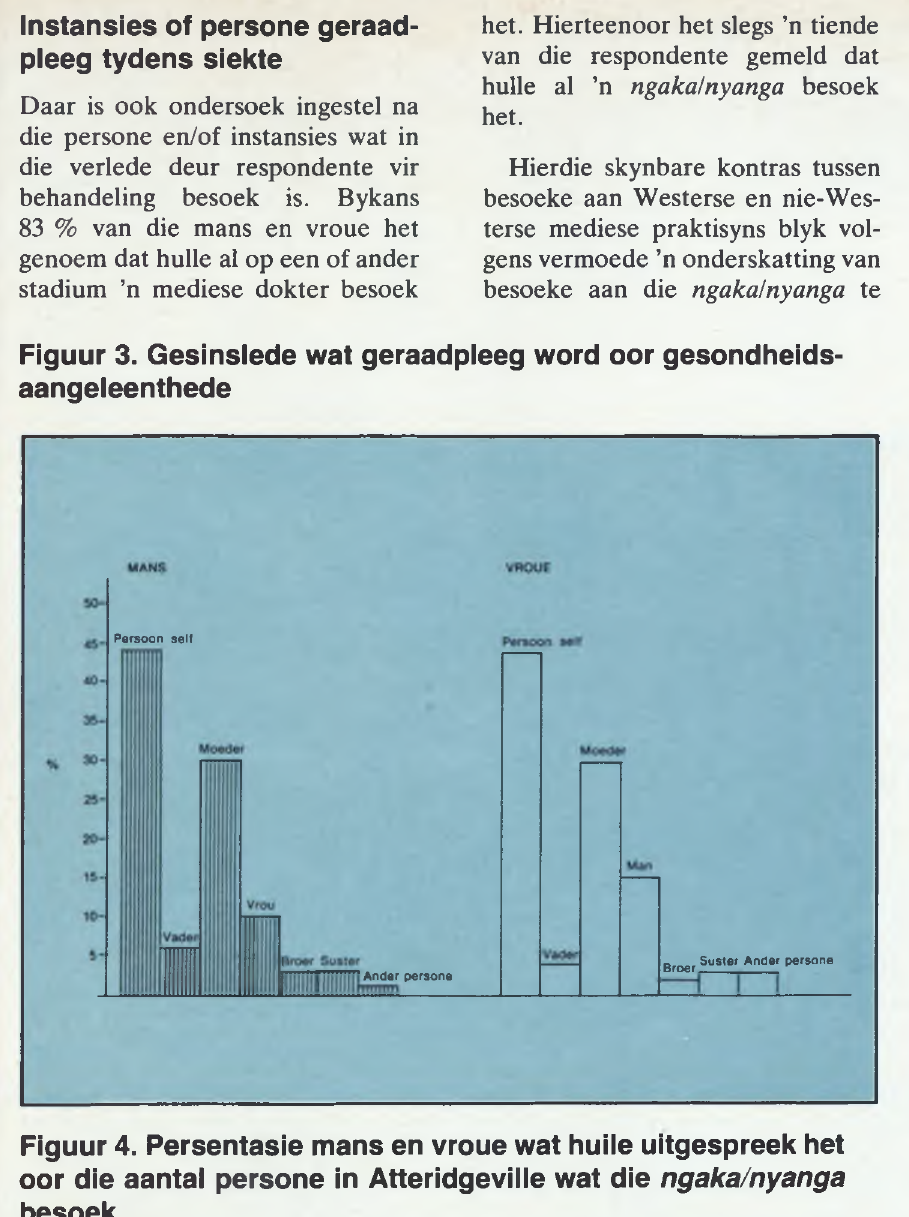
Figuur 4. Persentasie mans en vroue wat huile uitgespreek het oor die aantal persone in Atteridgeville wat die